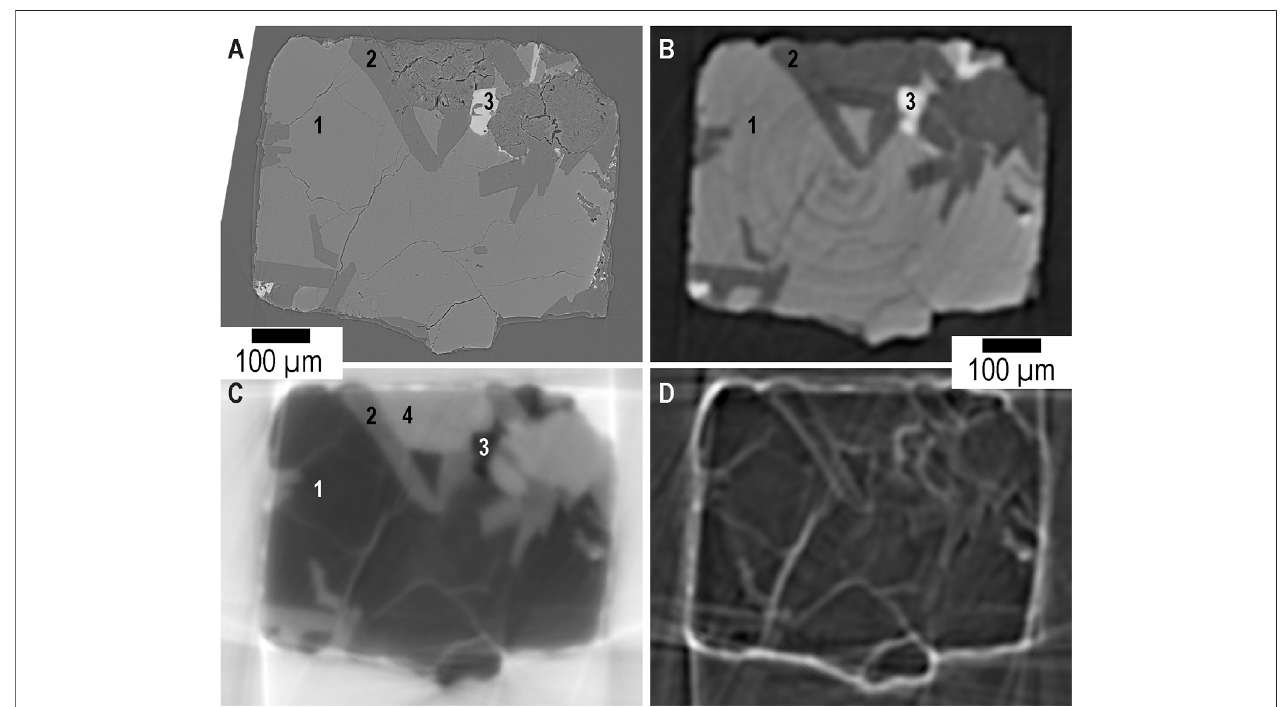
FIGURE3| Compared absorption-based SRCT and GB-SRCT imagingofapartiallyaltered crystalline basalt. (A) High-resolution absorption-based SRCT slice(1 voxel =0.325 µm). Based on gray intensity values, 3distinctconstituents(labelled 1 – 3)can be observed. Note that Paganin phase retrieval (Paganin et al., 2002) did not led to an increase in absorption-based tomographic image quality ( Supplementary Figures S3 ). (B) The transmission signal acquired during GB-SRCT (1 voxel = 6.5 µm) where the 3 constituents are also visible. (C) The DPC signal resulting from the small angle refraction of different constituents within the partially altered basalt. Compared to (A) , one additional constituent (labelled 4) is visible. Constituent 1 is likely pyroxene, constituent 2 is plagioclase, constituent 3 is titano-magnetite, and constituent 4 is clay. (D) The dark- fi eld signal, produced by local scattering, can be used to observe interfaces and fractures within the crystalline basalt. Associated distributions of gray intensity values and segmentation by global thresholding are provided in Supplementary Figures S5, S6 , respectively.